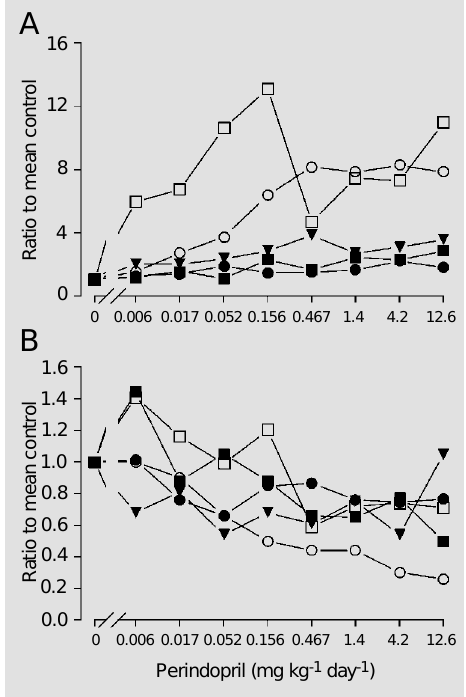
Figure 5 - Dose-response effects of perindopril on BK-(1-9) levels (A) and BK-(1-7)/BK-(1-9) ratios (B) in plasma (open circles), kid- ney (filled circles), lung (tri- angles), heart (filled squares), and aorta (open squares) of nor-